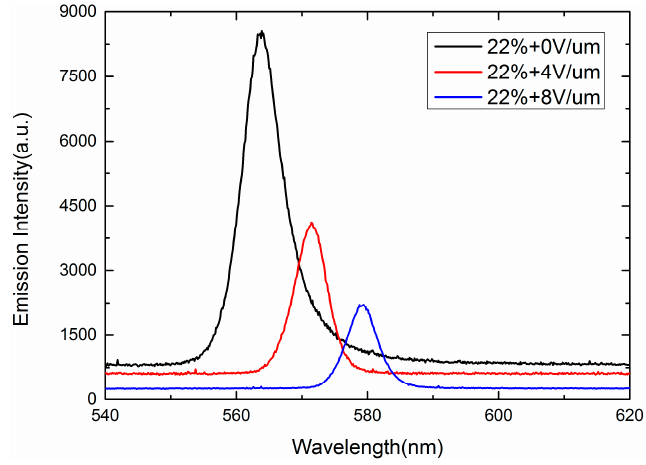
Figure 10. Measured emission spectra of sample D under different electric fields.